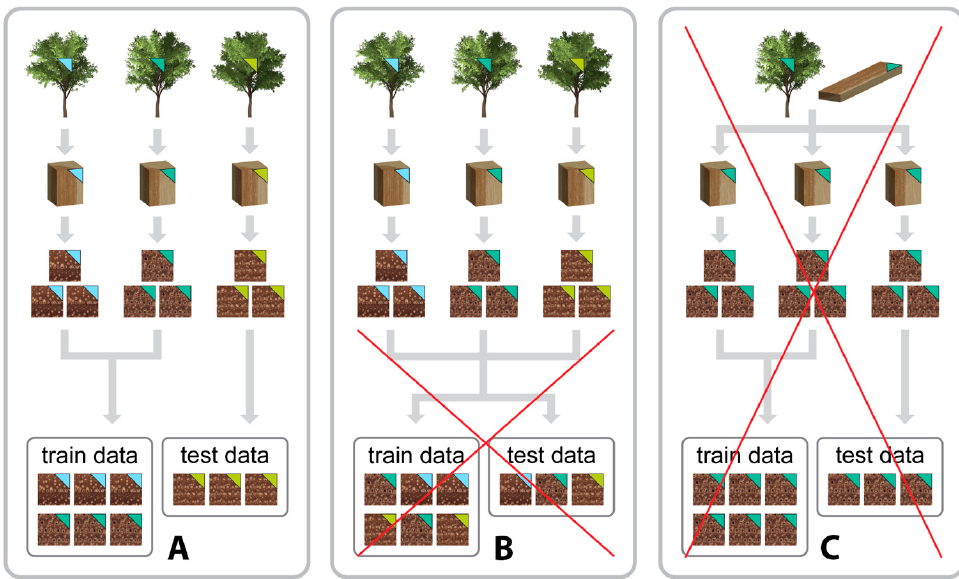
Figure 1. Illustration of three data hygiene scenarios for computer vision-based wood identification (CVWID) training and evaluation using a single class with three specimens. ( A ) Dataset develop- ment in accordance with the foundational principles, wherein multiple unique specimens (from dis- tinct trees) are used for dataset collection and mutual exclusivity at the specimen level between the training and testing folds is maintained. ( B ) A scenario where the evaluation is flawed because of specimen level data leakage between the training and testing folds even though multiple unique specimens (from different trees) were used in the dataset. Correct partitioning into training and testing folds (as shown in ( A )) salvages this scenario. ( C ) A scenario that violates the baseline quality standards for dataset collection precluding valid performance evaluation—this is not salvageable and typically occurs when specimens from teaching collections or other non-scientific collections (in which individual specimens are not traceable) are used for data collection. The CVWID lifecycle : The design, implementation, and evaluation lifecycle of a CVWID system comprise the prototyping and iterative refinement of the following stages (Figure 2): Context definition : The scope of a field operational CVWID system is defined by the set of woods the system must identify (e.g., continental, national, regional scale); the gran- ularity of the identification (e.g., species/genus level identification (multi-class classifica- tion); endangered/controlled vs. non-controlled (binary classification)); and, the risk of a misidentification (not all misidentifications are considered equal, e.g., misidentifications within a genus versus out-of-genus misidentification; misidentification of a high-value timber as low value versus the converse). Expertise in wood anatomy and compliance enforcement is critical for identifying and defining a practical, well-posed context. Data collection : Data collection for CVWID comprises the following steps: specimen acquisition, specimen surface preparation, and prepared specimen surface imaging. To enable the training of accurate CVWID models and their valid evaluation, the images in the dataset must be obtained from verified specimens, consistently capture the relevant wood anatomy, and the dataset as a whole must capture the typical inter- and intra-class variability. Model training : The two components of a CVWID model are a feature extractor (which computes a “signature” that encodes the wood anatomy patterns visible in an image) and a classifier (a learnable, parametrized function that maps image signatures to class labels). Models used for identification can be shallow (hand-crafted feature extractors with